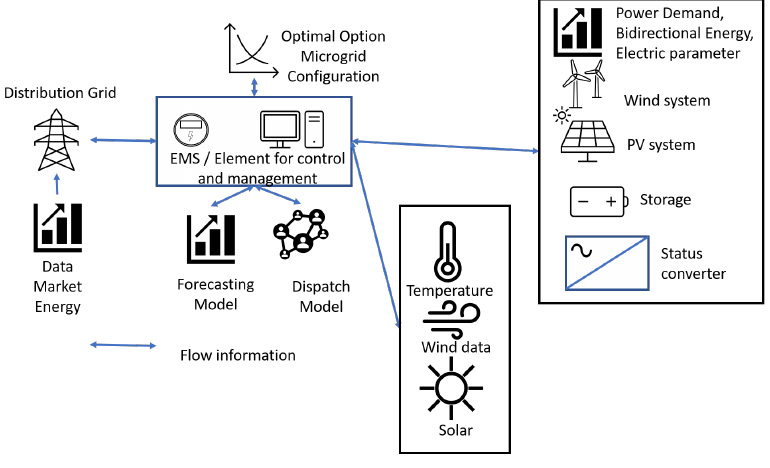
Figure 3. EMS information flow.